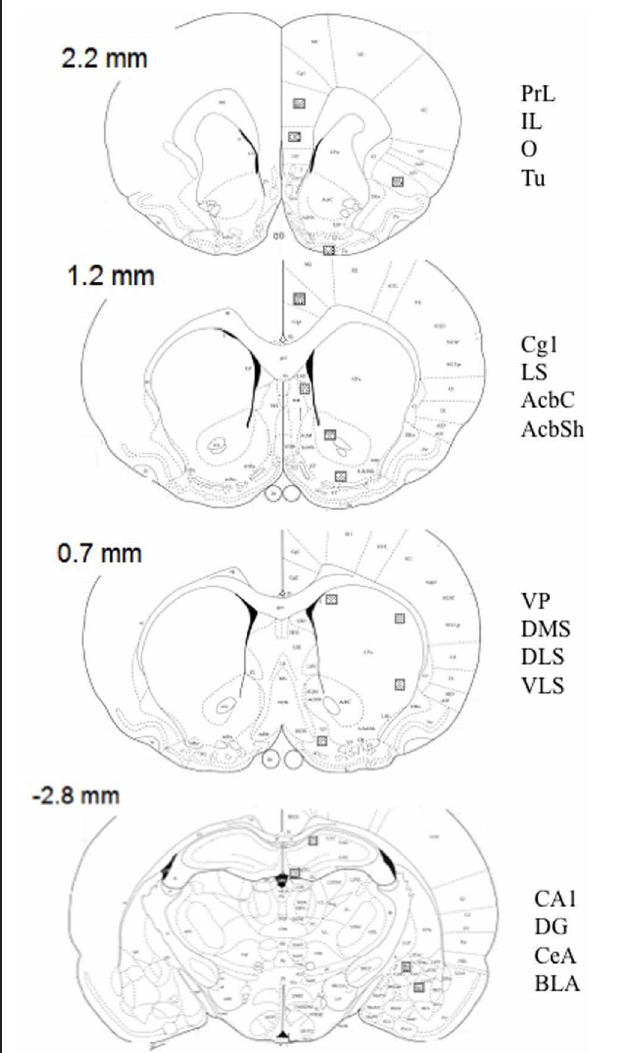
FIGURE 1 | Schematic diagrams of relevant coronal levels and specific brain regions depicted in Tables 1–6, and Figures 4, 5 [based on the atlas of Paxinos and Watson (1998)]. The squares indicate the placement of optical dissectors for counting c-Fos positive cells. Numbers represent bregma at every coronal level. AcbC, accumbens core; AcbSh, accumbens shell; BLA, basolateral amygdala; CA1, CA1 of the hippocampus; CeA, central amygdala; Cg1, cingulate cortex 1; DG, dentate gyrus; DLS, dorsolateral striatum; DMS, dorsomedial striatum; VLS, ventrolateral striatum; IL, infralimbic cortex; LS, lateral septum; O, orbitofrontal cortex; PrL, prelimbic cortex; Tu, lateral tubercle; VP, ventral pallidum.